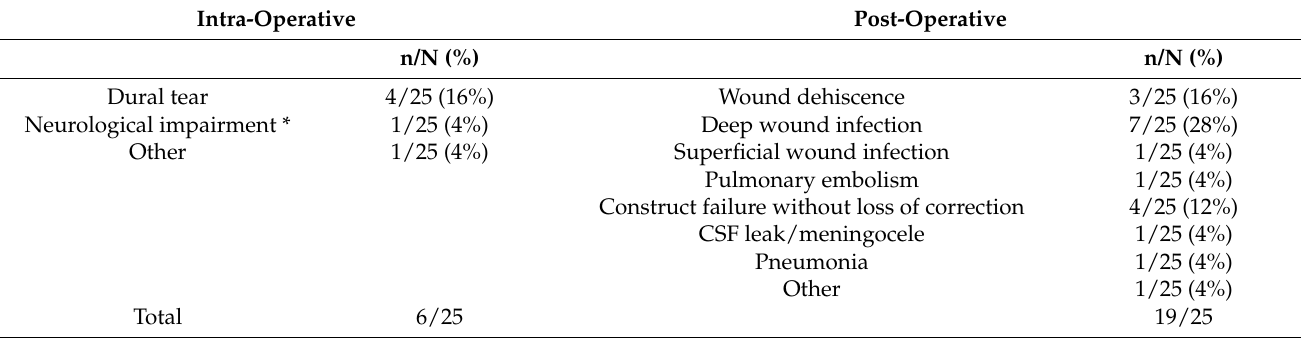
Table 3. Intra-operative and post-operative complications.